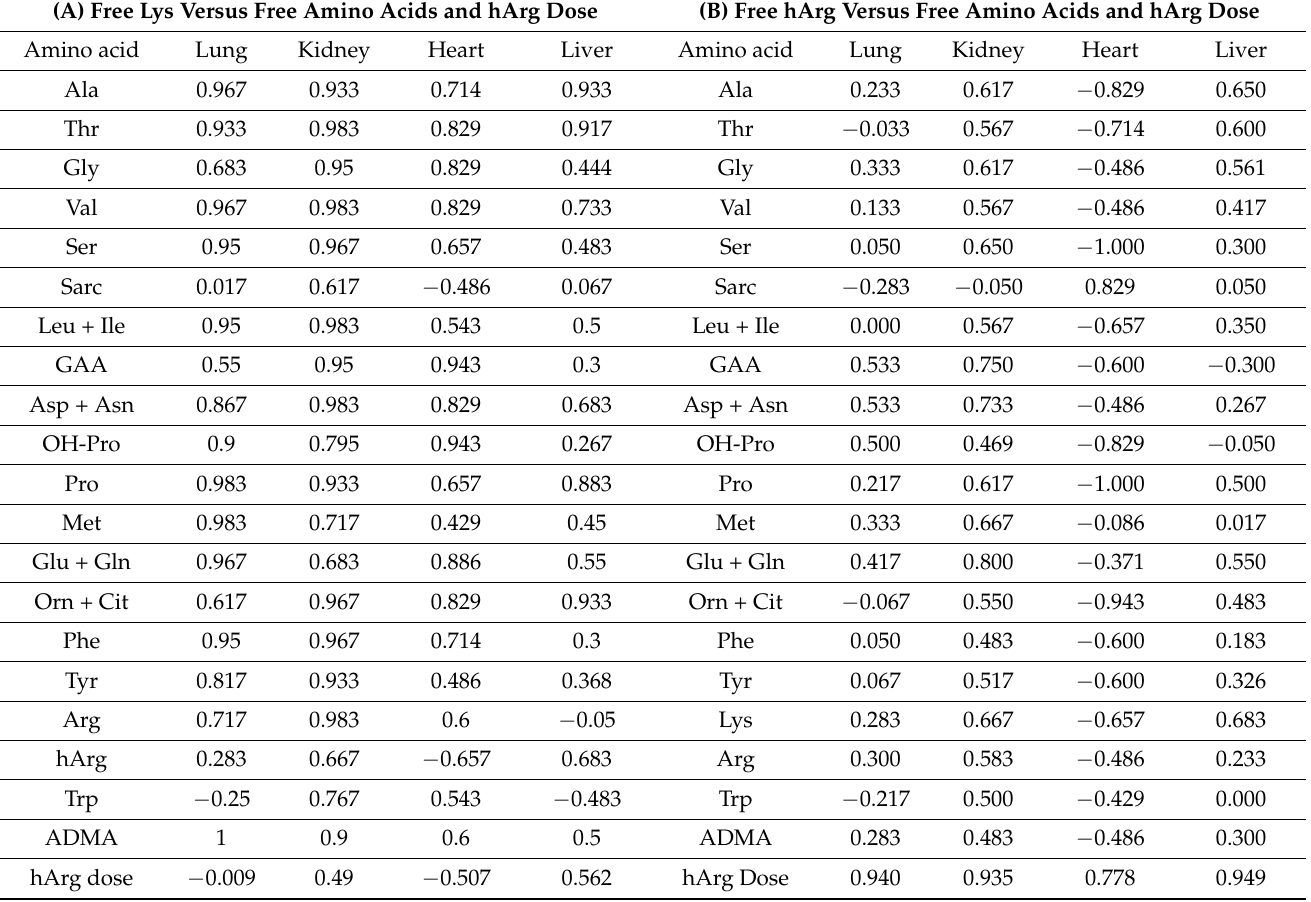
Table 3. Spearman coefficients of correlation between the tissue concentrations ( µ M) of (A) free Lys and (B) free hArg with the indicated free amino acids in lung, kidney, heart, and liver of the rats. (B) Free hArg Versus Free Amino Acids and hArg Dose